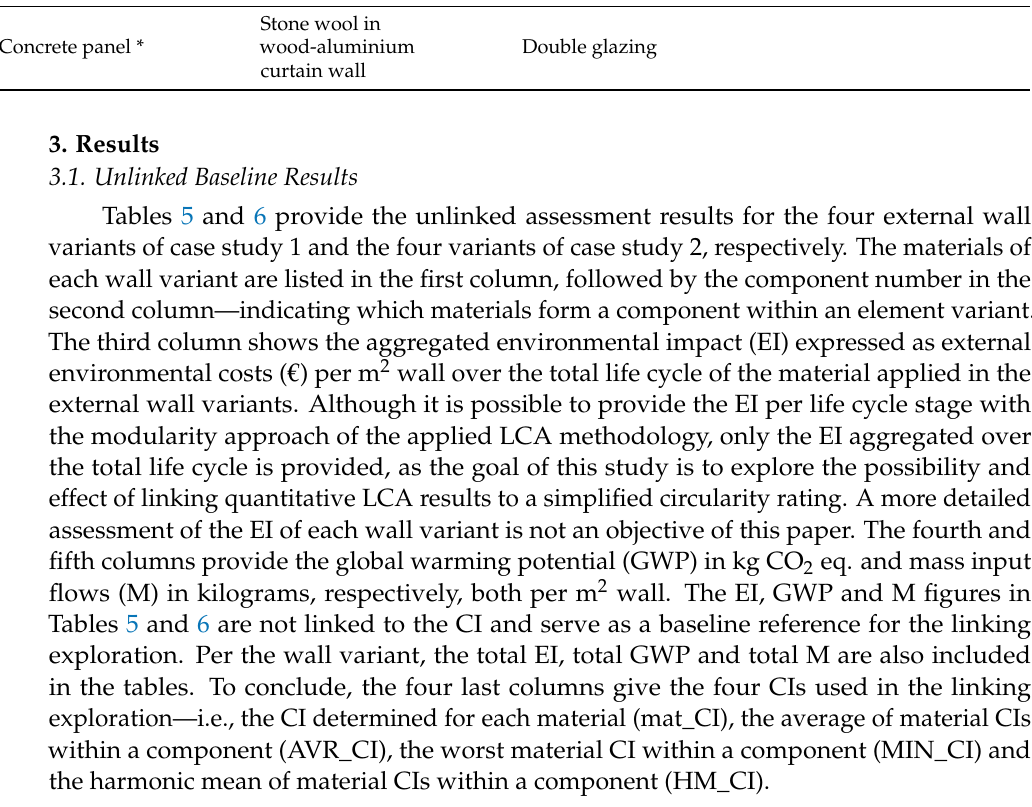
Table 5. Baseline aggregated environmental impact (EI) results, global warming potential